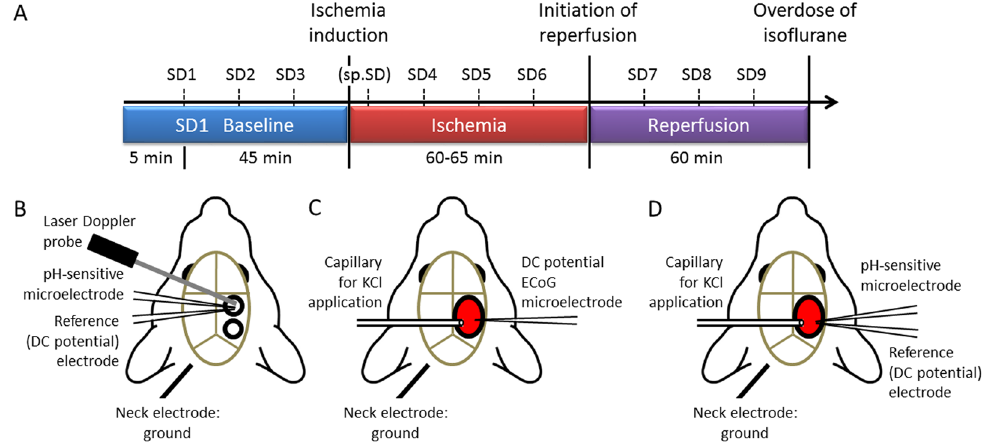
Figure 7. Experimental paradigm and models. ( A ) Schematic illustration of the experimental protocol. Numbered spreading depolarization events (e.g. SD1, SD2, … SD9) indicate SDs evoked by 1 M KCl application. Spontaneous SD (sp.SD) evolved in some but not all experiments, and is given in brackets due to its inconsistent occurrence. Ischemia and reperfusion was induced by the occlusion and latter release of both common carotid arteries. ( B–D ) Experimental preparation for the various data acquisition protocols used. ( B ) Conventional electrophysiological setting. Two open cranial windows were created (black circles) over the right parietal cortex. The frontal window served as recording site for data acquisition, and the caudal window was used for SD elicitation by the topical application of 1 M KCl. ( C ) Preparation for multimodal imaging (Neutral Red fluorescence and laser speckle contrast analysis). A closed cranial window was built over the parietal cortex and subsequently loaded with Neutral Red (black ellipse filled with red). The cranial window was equipped with a glass capillary to apply 1 μ l of 1 M KCl topically to elicit SD (left), and a glass capillary microelectrode to acquire direct current (DC) potential and electrocorticogram (ECoG) (right). ( D ) Combination of multimodal imaging (shown in panel B) with conventional electrophysiology (shown in panel